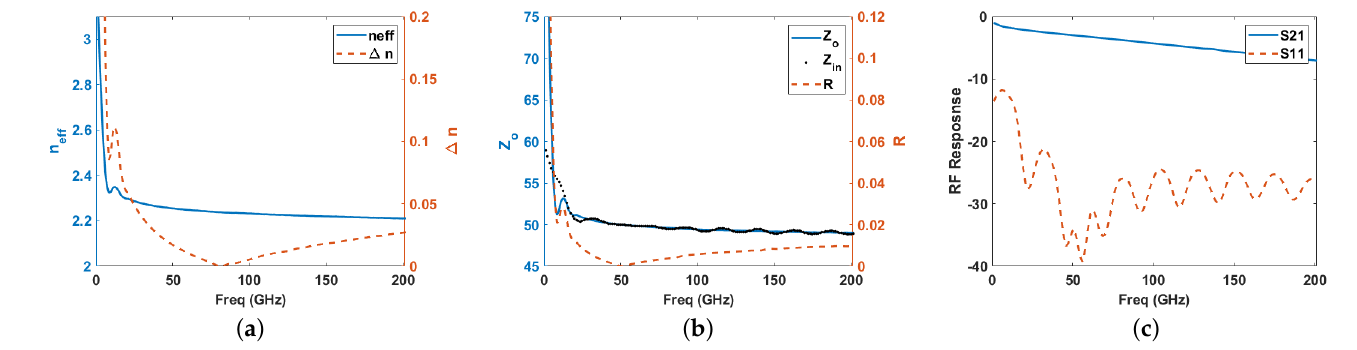
Figure 5. ( a ) n eff (and ∆ n), ( b ) Z o (Z in and R) and ( c ) RF response of the CPW for the design parameters versus RF frequency.